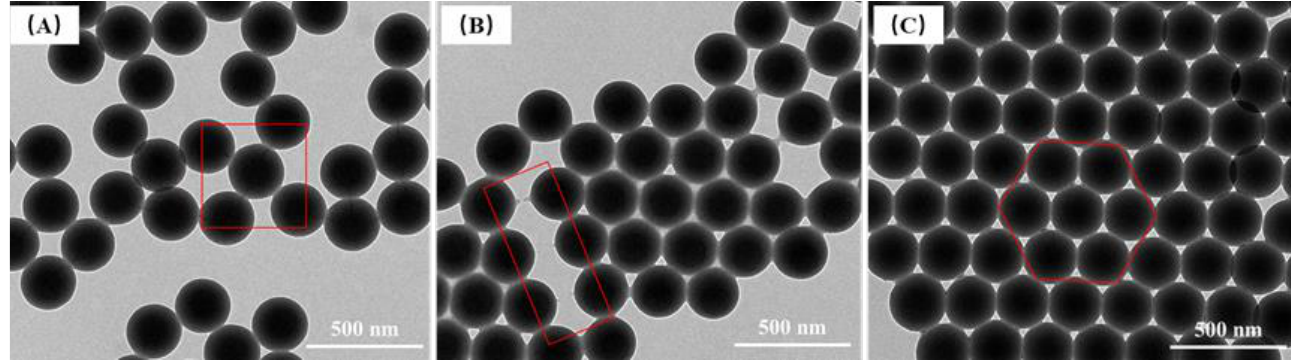
Figure 13. TEM images of P(St-AA) colloidal microspheres synthesized at different temperatures to illustrate the structure and diameter of the core-shell microspheres. ( A ) 70 °C; ( B ) 85 °C.